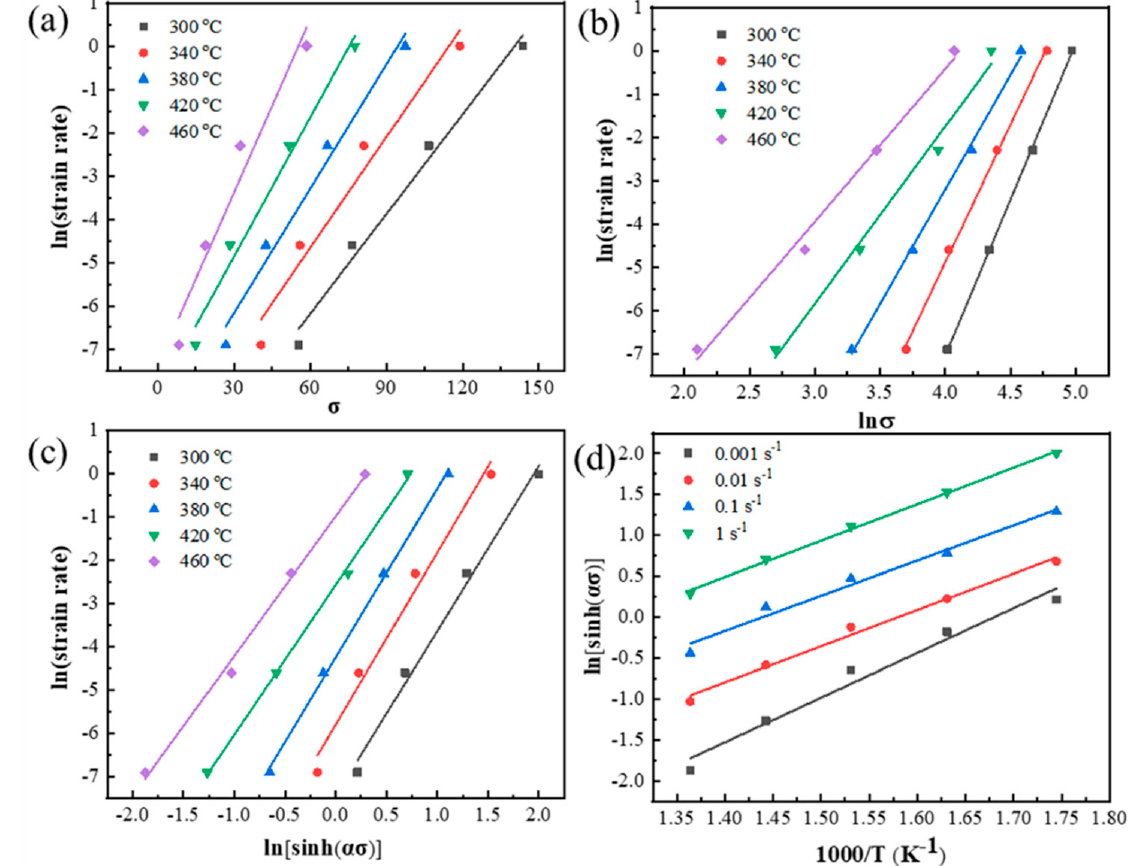
Figure 3. The correlations of ( a ) ln